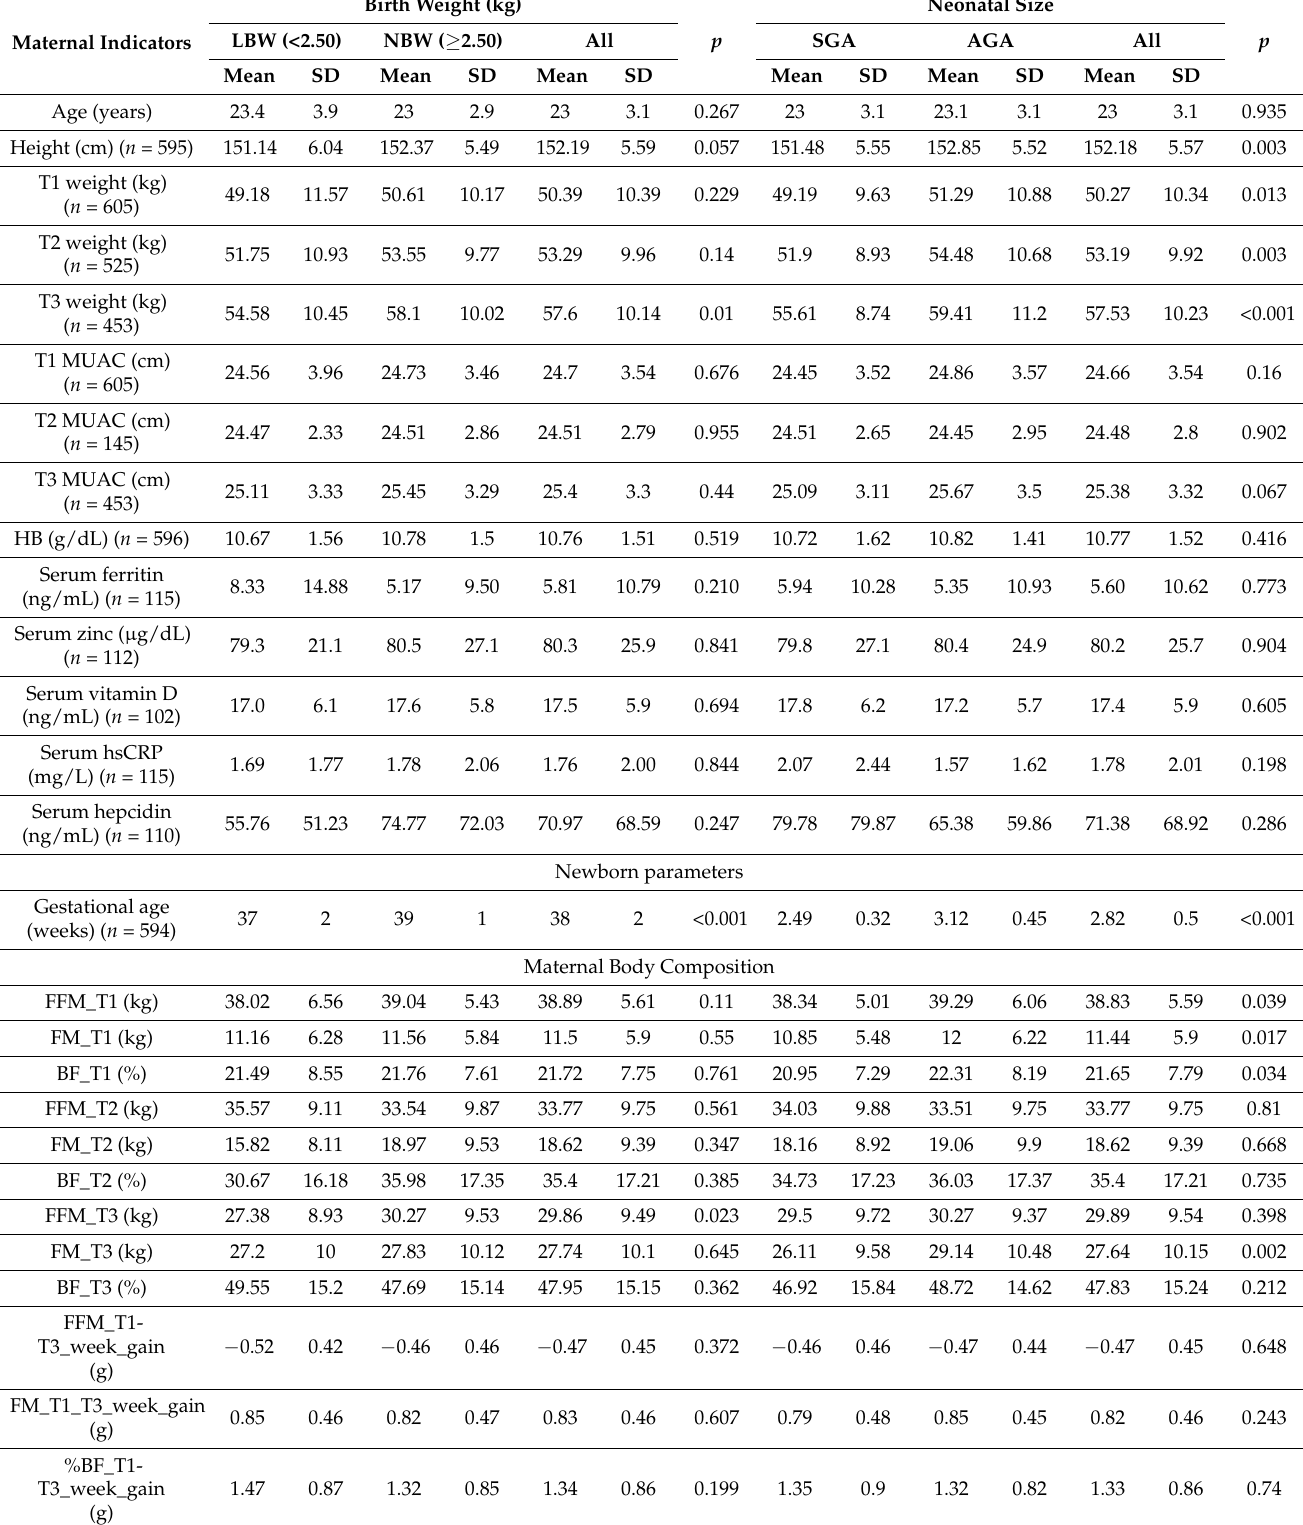
Table 5. Birthweight based on mean maternal anthropometric indicators and body